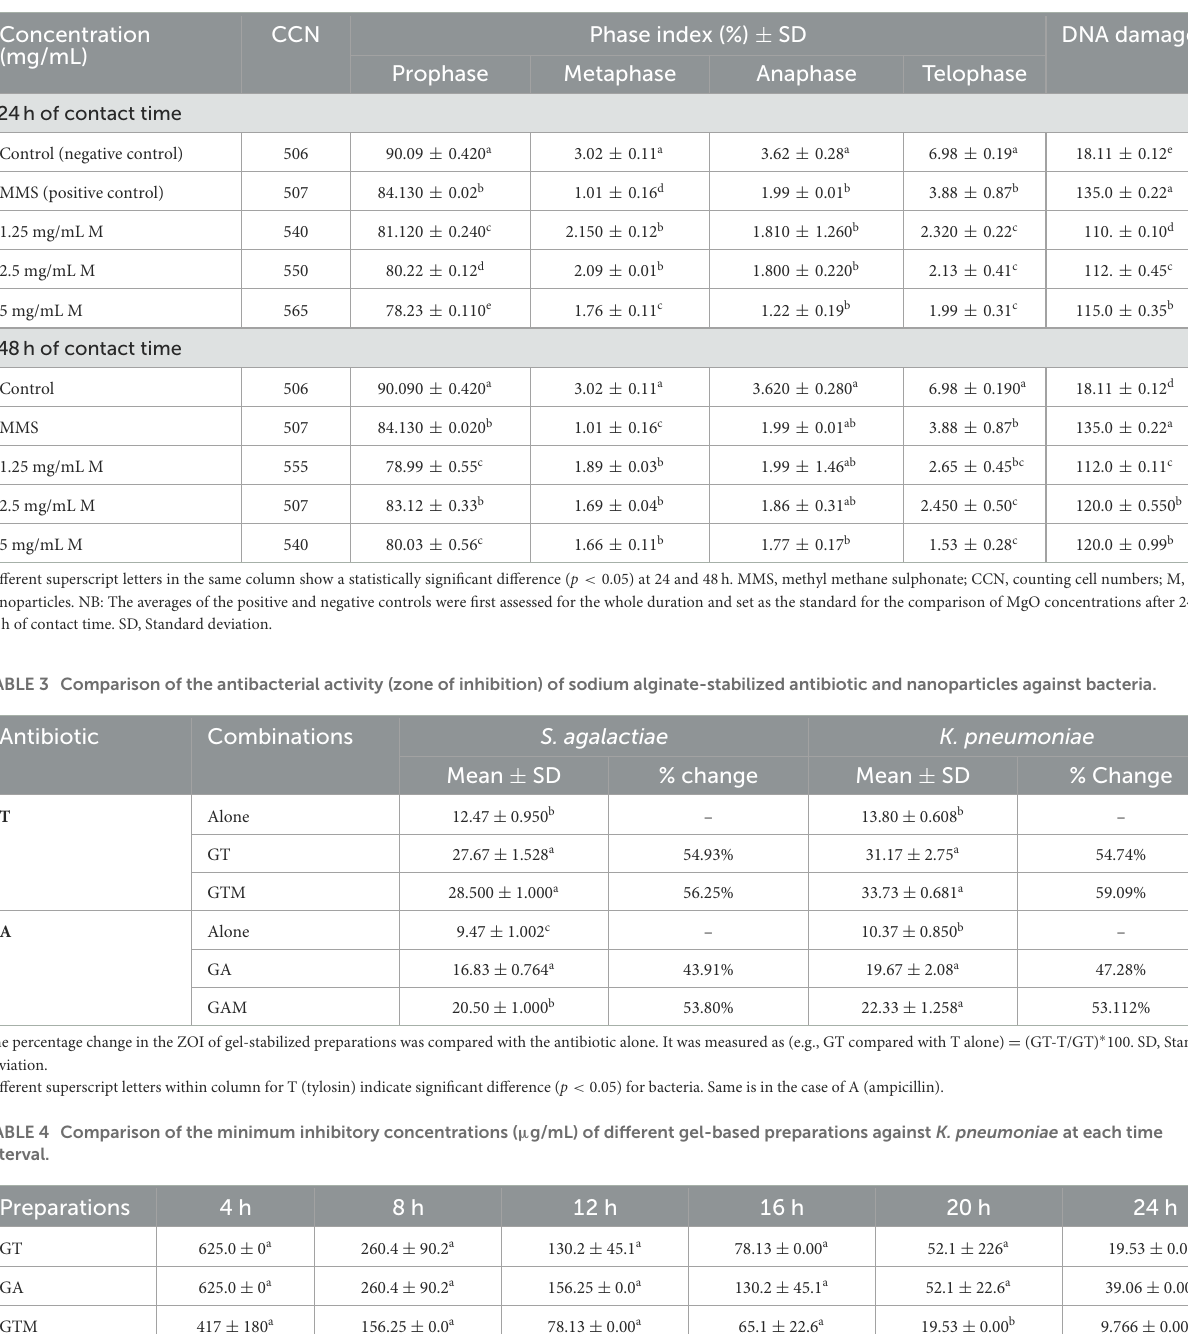
TABLE 2 Effect of magnesium oxide nanoparticles on the phase index and DNA damage in A. cepa .